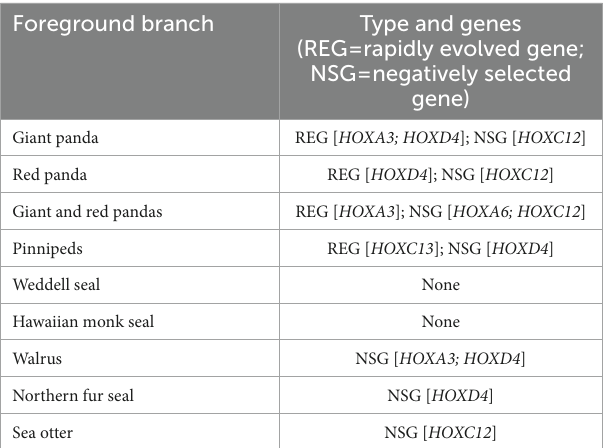
TABLE 2 Rapid evolution and negative selection based on the test results of both the two-ratio vs. one-ratio model and the two-ratio vs. free-ratio model.